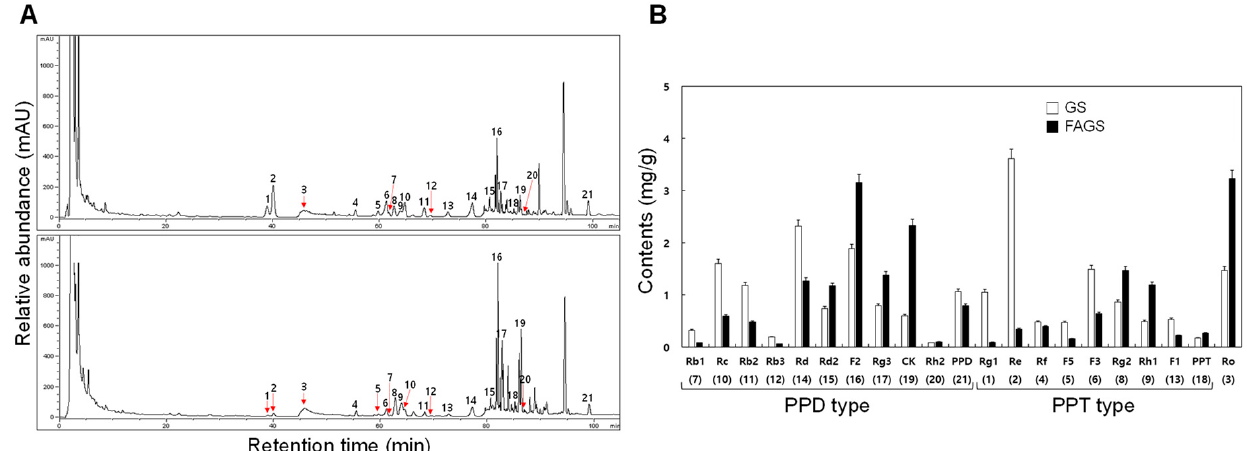
Figure 1. Typical HPLC chromatograms of GS and FAGS. ( A ) Relative ginsenoside contents of 50% ethanol-extract concentrates of GS and FAGS. Peaks are numbered. Arrows indicate less visible ginsenoside peaks. Numbers above the peaks indicating ginsenoside names are described in ( B ). ( B ) Comparison of ginsenoside contents in GS and FAGS. Peak numbers in parentheses indicate gin- senoside names, which are displayed below the bar graph. All values are presented as mean ± SD of pentaplicate determinations. GS and FAGS indicate ginseng sprouts and fermented and aged ginseng sprouts, respectively. PPT and PPD indicate protopanaxatriol and protopanaxadiol, respec- tively.